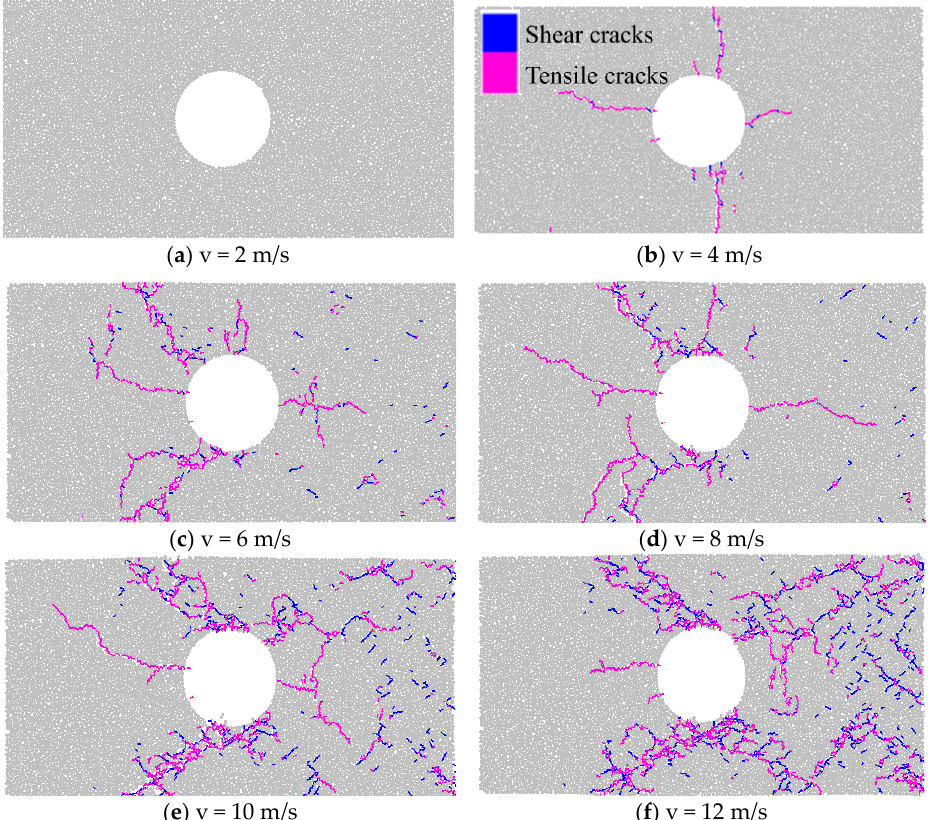
Figure 20. Failure mode around the hole under different amplitudes.